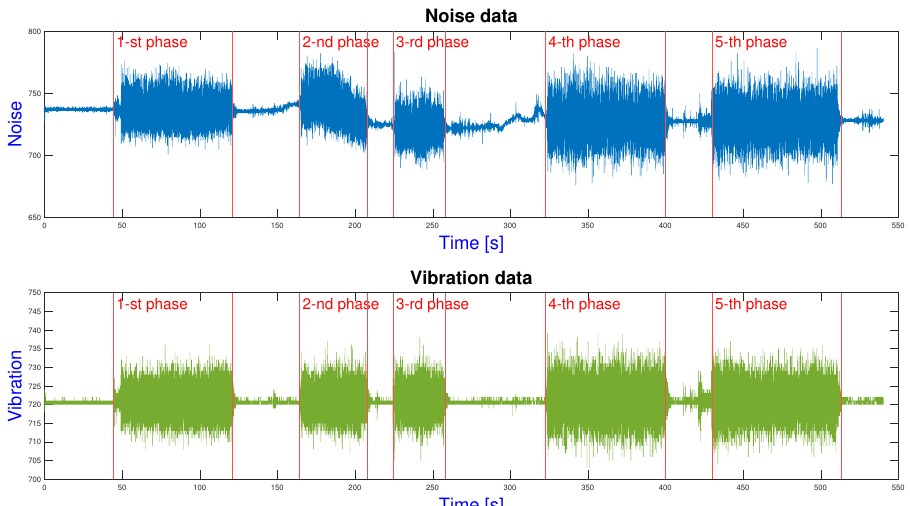
Figure 8. The different phases of machining identified based on the different characteristics of the noise and vibration data from the machine.